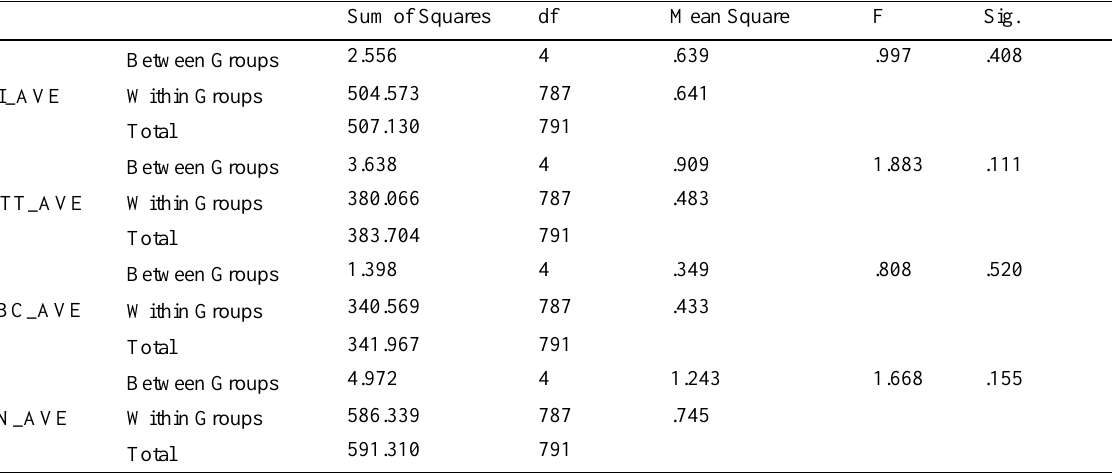
Table 13: ANOVA for Student and Graduate IEC due to Programme